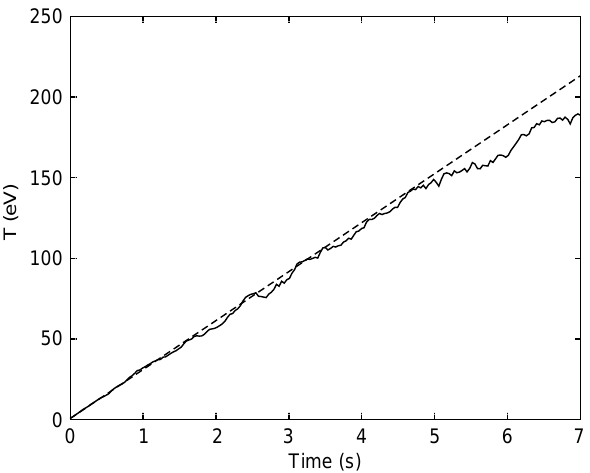
Fig. 5. The perpendicular temperature at v with constant amplitudes ( solid line ), compared with the theoretical value from Eq. (19) ( dashed )